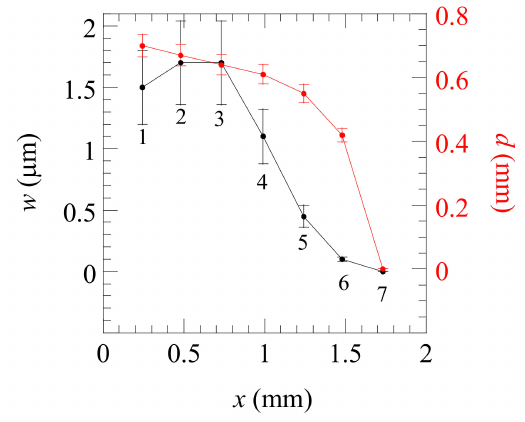
Figure 11. Fitted values of the width and depth of the crack for each of the seven positions marked in Figure 7. x corresponds to the distance to the hole. The lines are a guide for the